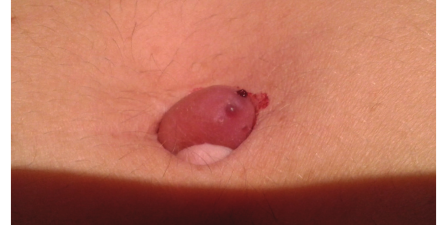
Figure 1: Umbilical nodule bleeding during menstrual cycle.